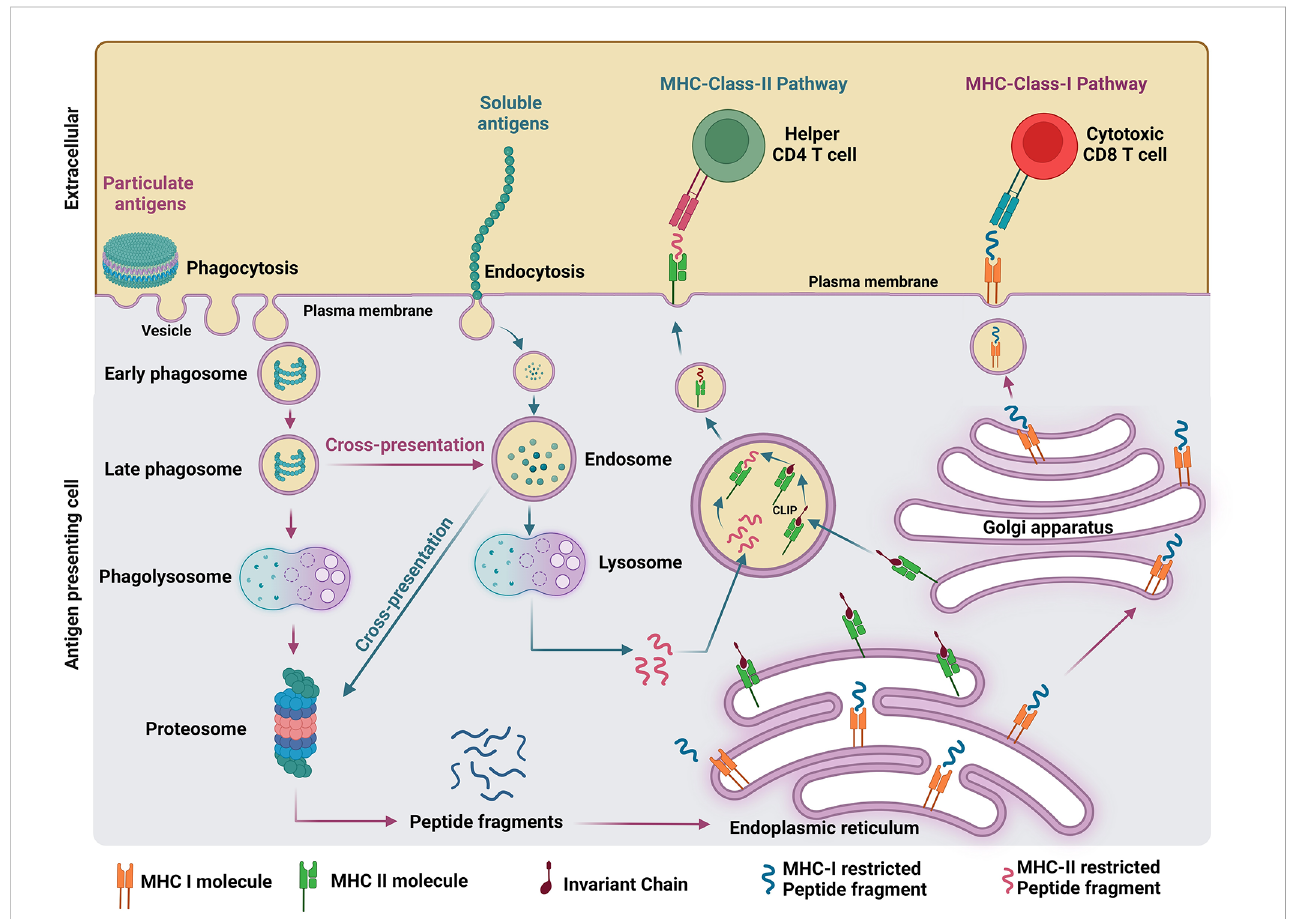
FIGURE 1 Comparison of antigen processing pathways elicited by soluble and particulate antigen